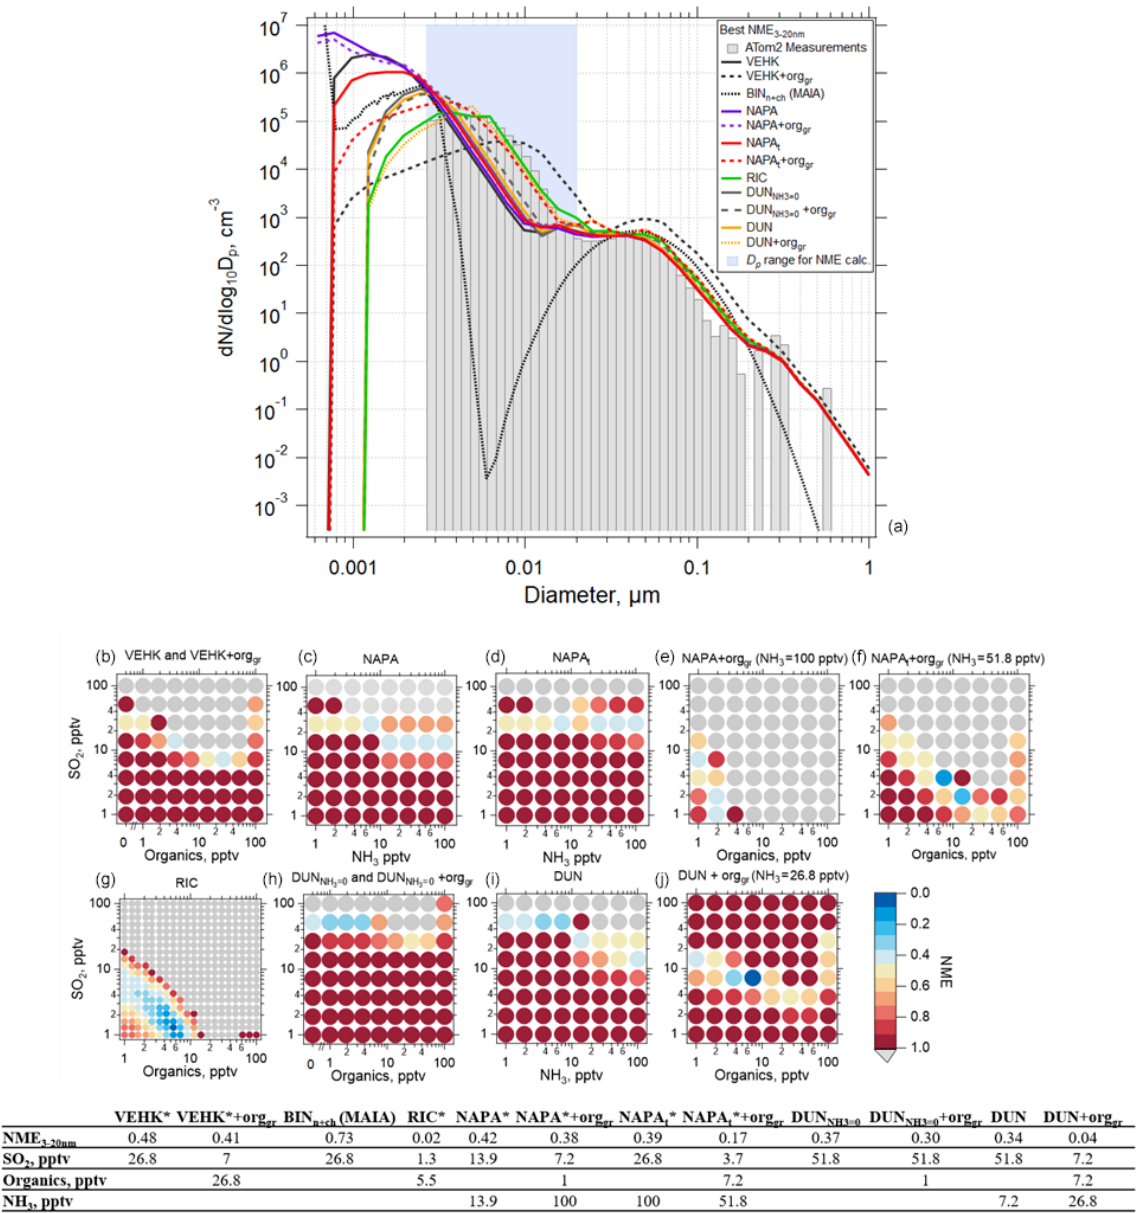
Figure 6. Results of simulations using the TOMAS box model for an example case (ATom 2, 4 February 2017, 03:05:31–03:06:30UTC; case identifier: sd486) where measurements were made 7.3h following convective influence, and temperature along the trajectory varied between 218 and 226K. (a) Observed (shaded bars) and simulated (lines) aerosol size distributions with best normalized mean error (NME) calculated for D p between 2.6 and 20nm (blue shading) for each of the NPF and growth schemes investigated. Best results from the MAIA box model ion-assisted + neutral binary nucleation scheme shown as a dotted black line. (b) NME between the modeled and measured size distribution for the VEHK scheme with varying organics mixing ratios for condensational growth. The color of the circle indicates the value of NME corresponding to a particular initial mixing ratio of SO 2 , NH 3 , or organics that varied between 0 and 100pptv. Blue represents the best agreement, red poorer agreement, and grey the worst (NME > 1). There were 64 sensitivity tests. (c) As in (b) but for the NAPA scheme. (d) As in (c) but for the NAPAt scheme. (e, f) As in (c) and (d) , respectively, but with NH 3 fixed and varying organics for condensation growth. (g) As in (b) but for the RIC scheme, which provides the lowest NME. There were 400 sensitivity tests for this scheme. (h) As in (b) but for the DUN scheme with NH 3 set to 0 (DUN NH ). (i) As in (c) but for the DUN scheme. (j) As in (i) but with varying organics for 3 = 0 condensation growth. The table presents the NME results for the corresponding size distributions in (a) and associated initial mixing ratios of gas-phase